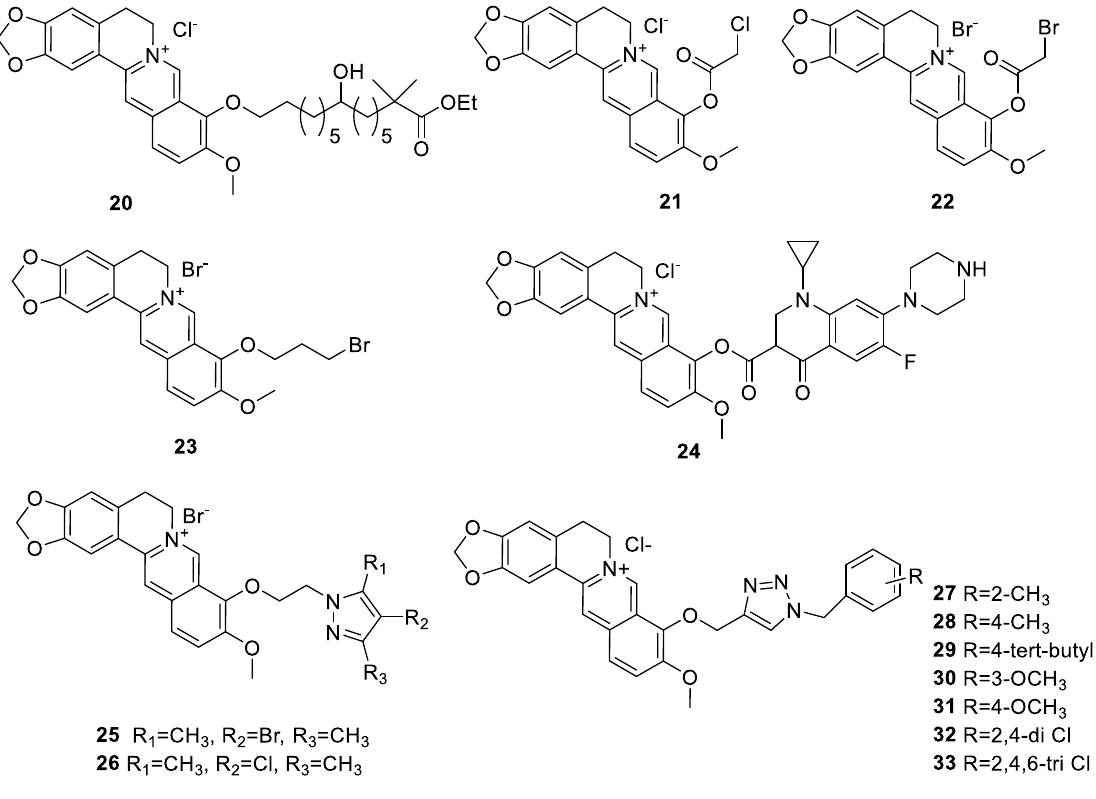
Figure 3. Berberine-9- O -derivatives [124 – 127]. Molecules 2020 , 25 , x 17 of 31